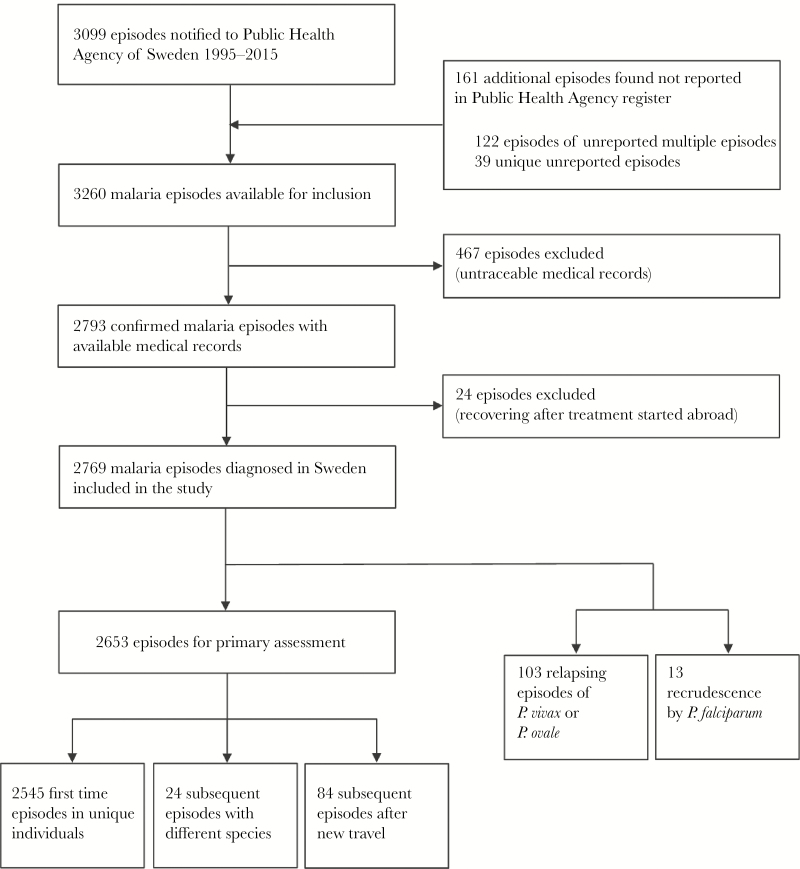
Chart of study population.